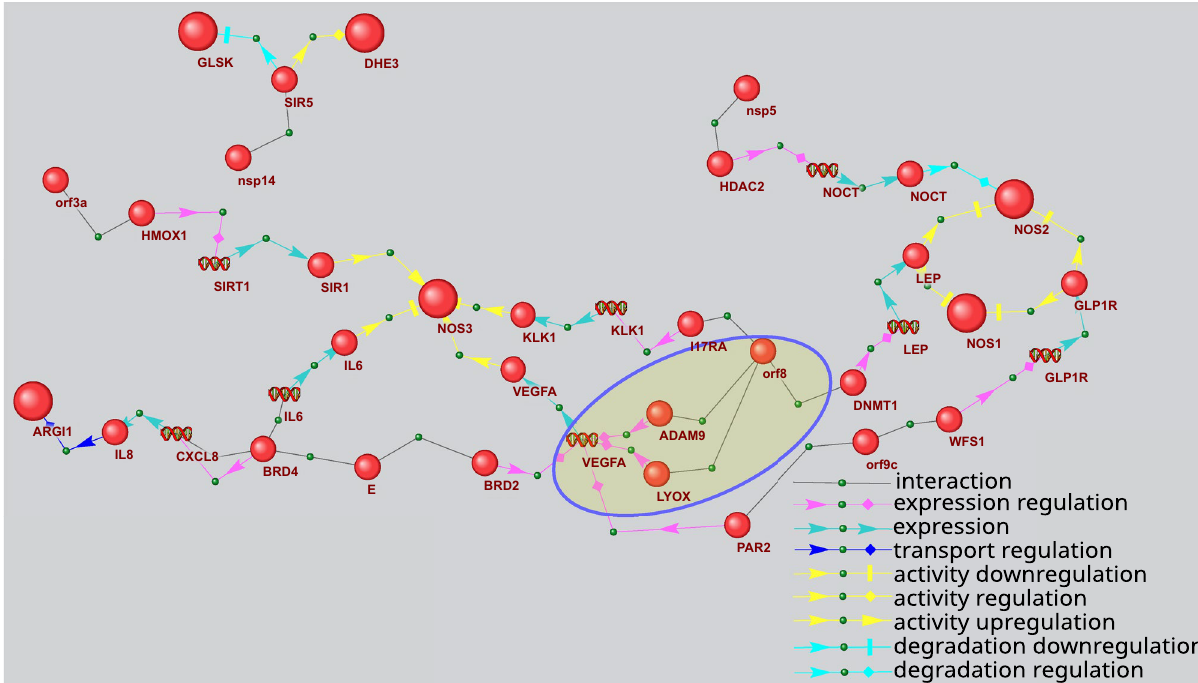
Figure 8. Gene network describing P 3 and P 6 pathways regulating activity/stability of arginine biosynthesis enzymes by viral proteins. The bigger balls show the proteins of arginine biosynthesis, while the smaller ones designate other proteins. Spirals designate the genes. The pathways discussed in the text are outlined.